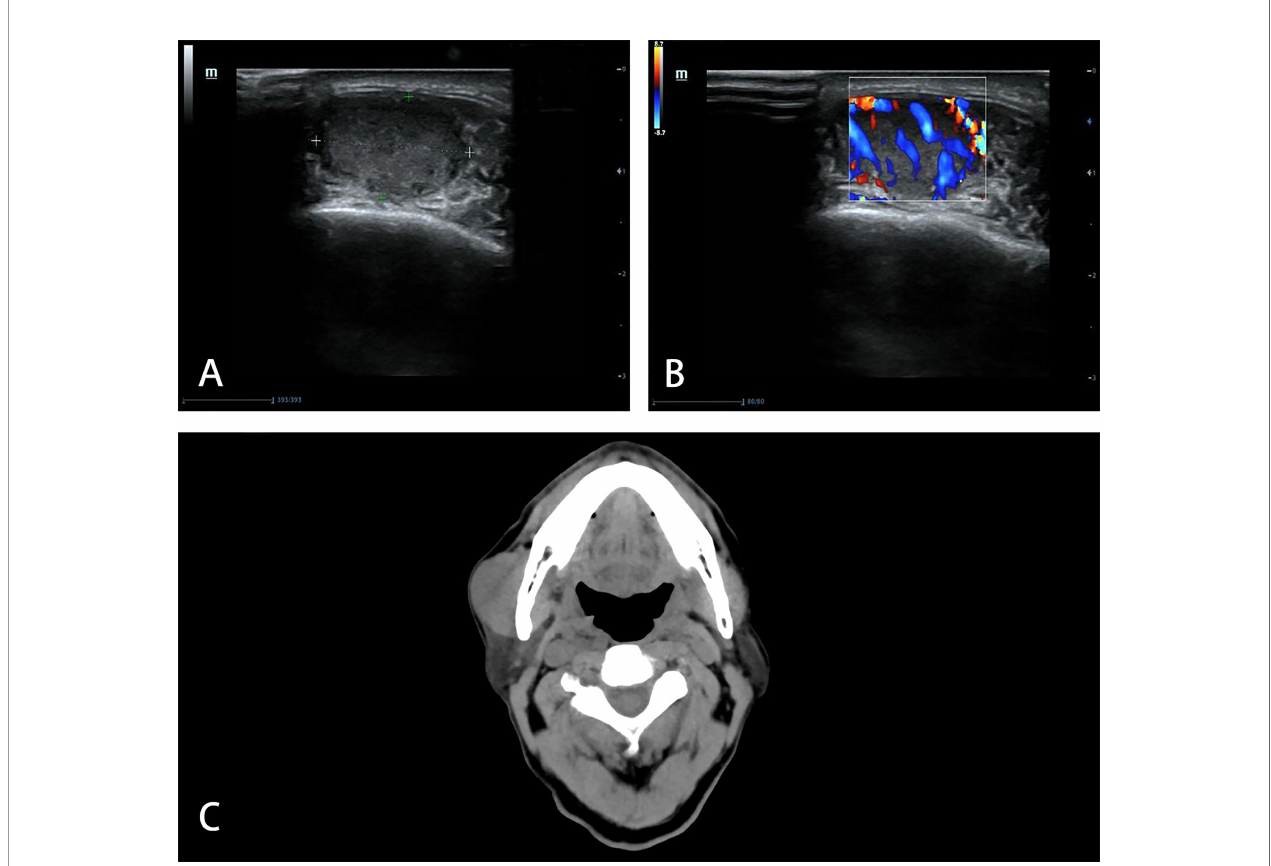
FIGURE 1 | Imaging manifestations of masseter muscle metastasis in US and CT. US shows a hypoechoic (A) , hypervascular (B) mass in the muscle layer of the masseter area in 2019. CT shows unclear boundary between the mass and right masseter muscle in 2021 (C)